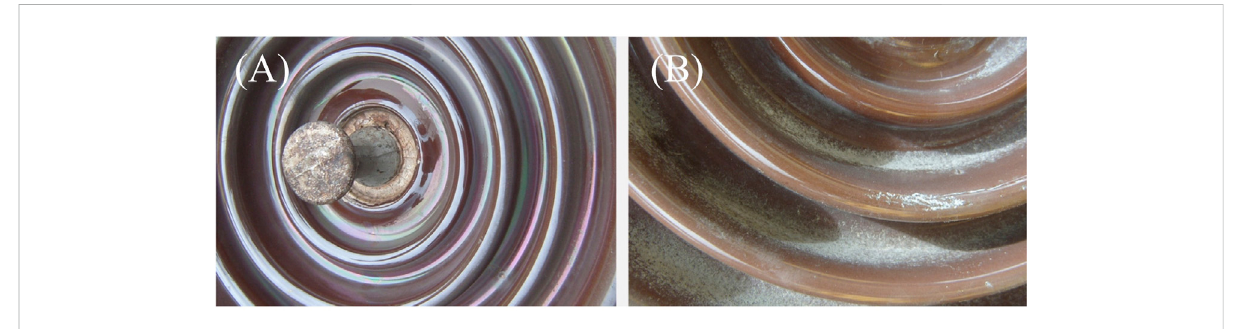
FIGURE 7 The images of (A) the coated TiO 2 coating and (B) the uncoated TiO 2 coating insulators tested in service in Balsillas during 5 months (Castaño et al.,